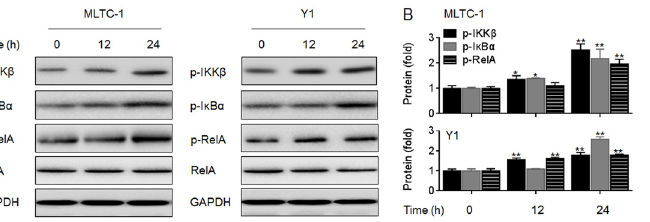
Fig 7. Effects of MBP on the activation of NF- κ B. MLTC-1 and Y1 cells were exposed to 1000 nM MBP for 0, 12, or 24 h, respectively. (A) Western blots analysis and (B)relative protein levels of p-IKK β , p-I κ B α , and p- RelA. * p < 0.05 and ** p < 0.01 compared with medium control cells.